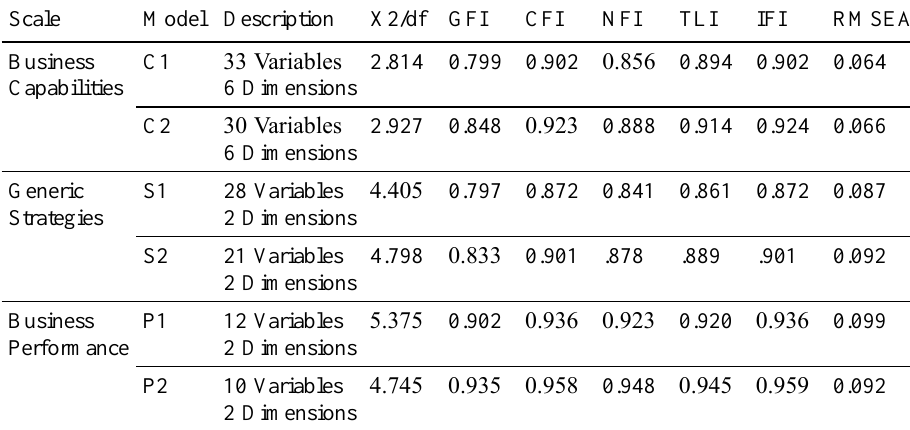
Table 2. Model fit indexes